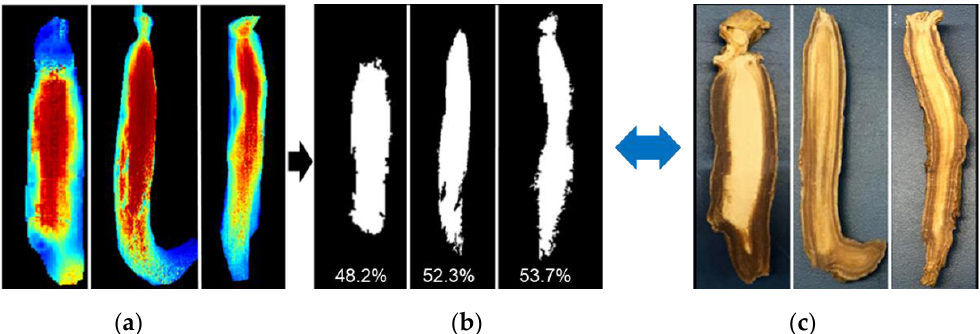
Figure 8. ( a ) Nondestructive ratio image visualizing the whitening region (red pixels) in abnormal ginseng samples; ( b ) binary image of detected whitening region; ( c ) color images of sliced abnormal ginseng samples for comparison.